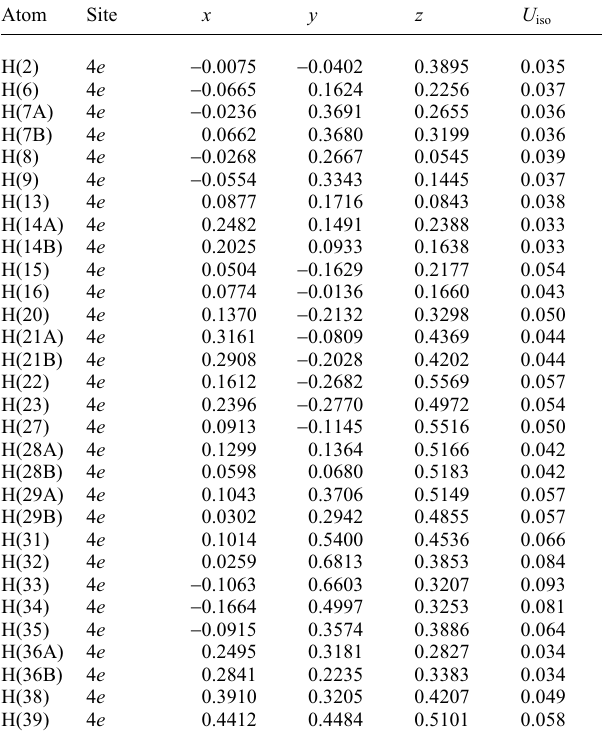
Table 2. Atomic coordinates and displacement parameters (in Å 2 )